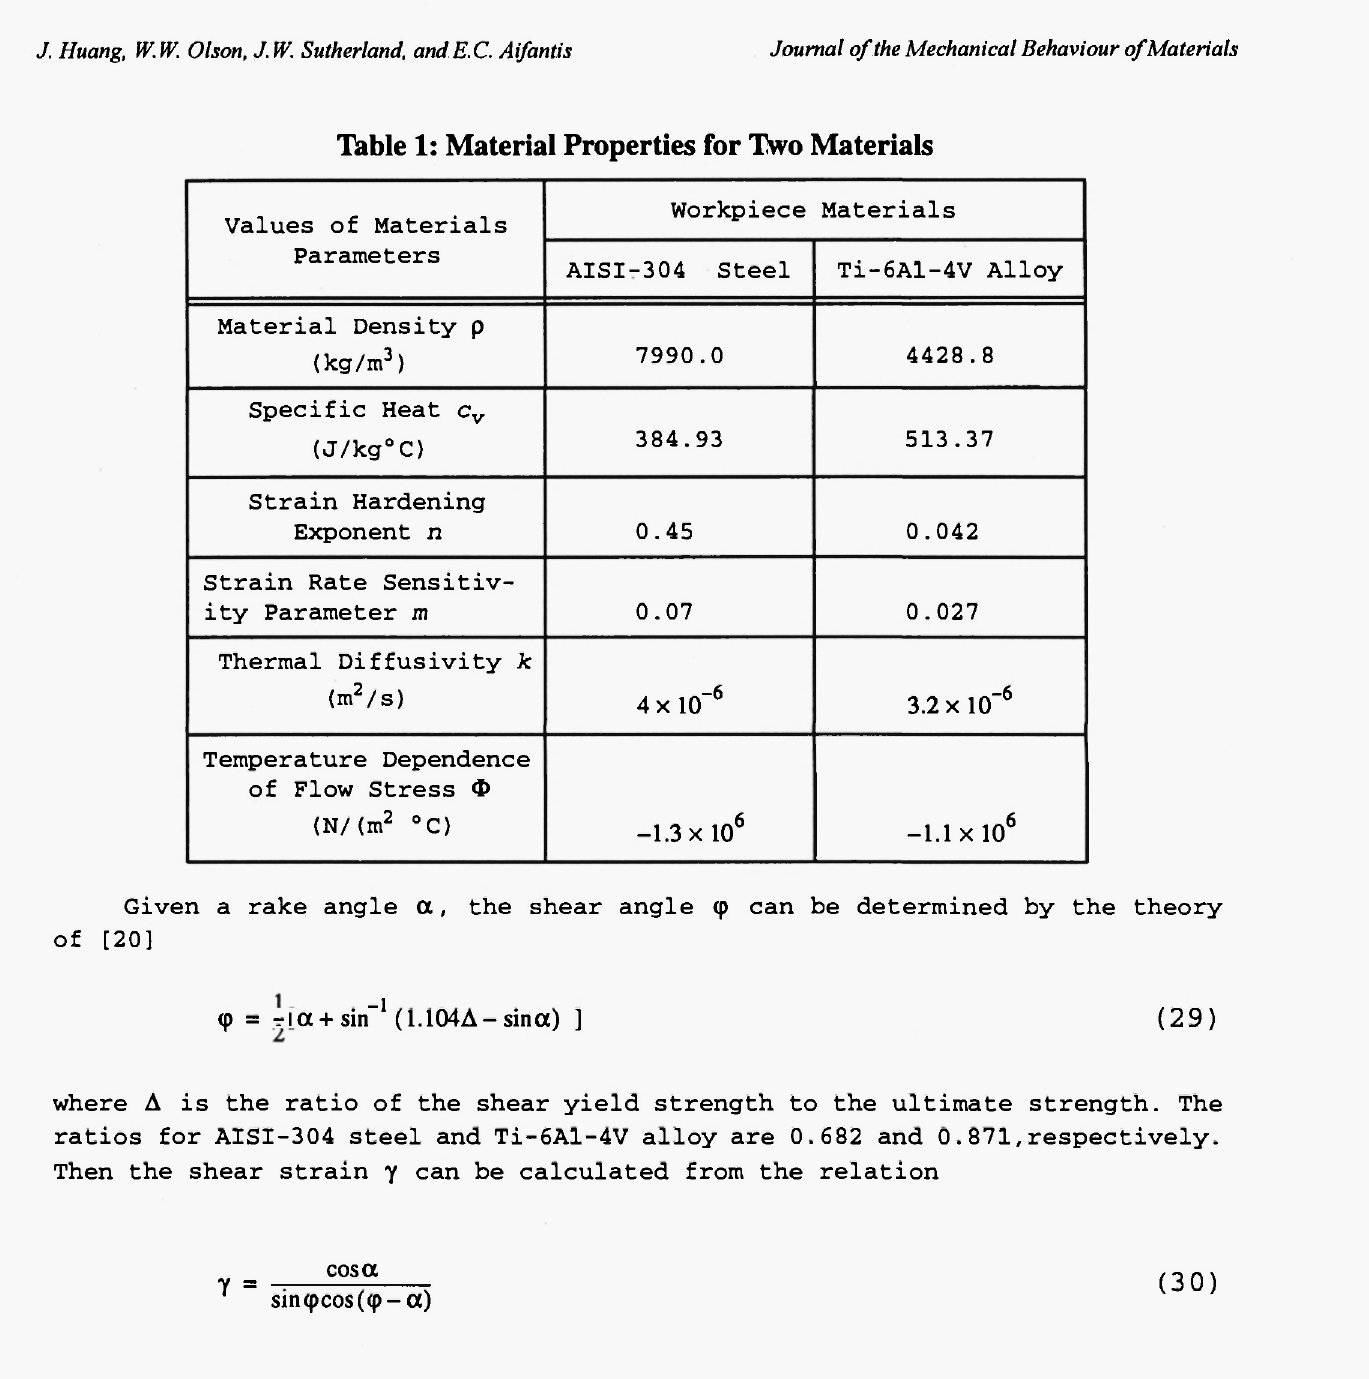
Table 1: Material Properties for Two